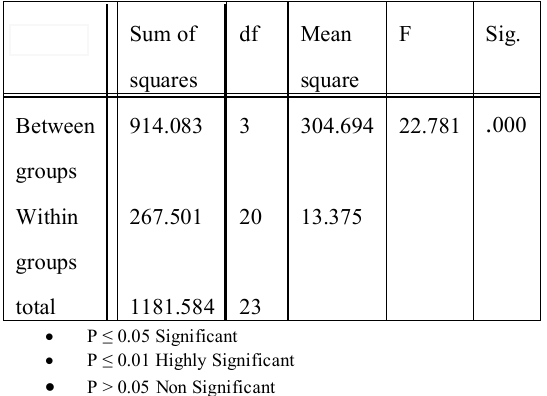
Table (1): Summery statistic of removal